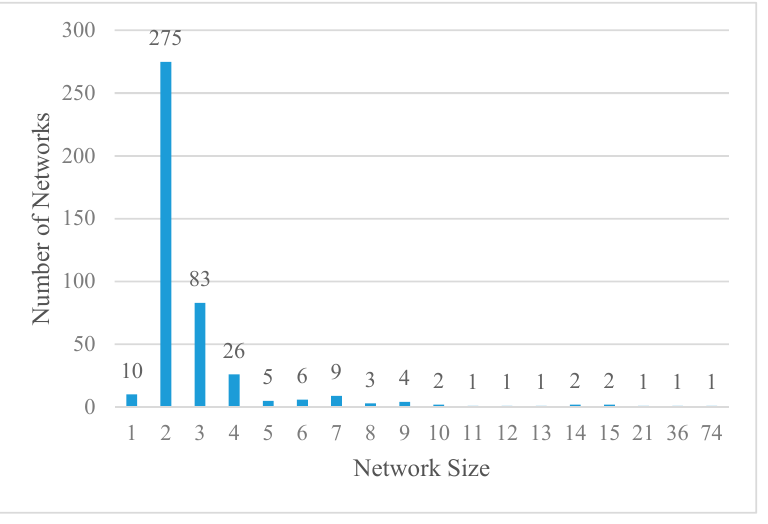
Figure A1. Network size and number.